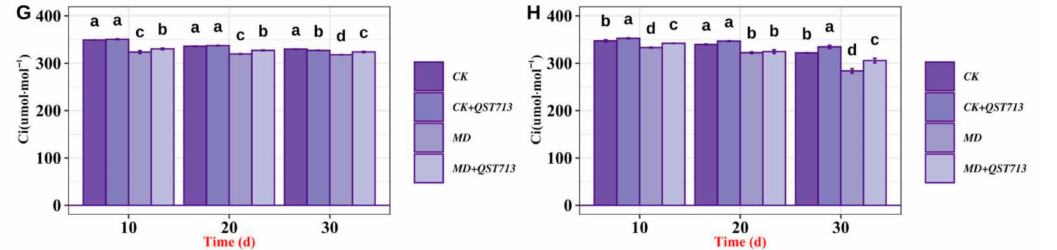
Figure 2. Effect of drought stress and QST713 application on photosynthetic rate (Pn; ( A , B )), transpi- ration rate (Tr; ( C , D )),stomatal conductance (Gs; ( E , F )) and intercellular CO 2 (Ci; ( G , H )) of alfalfa seedlings in two cultivars (( A , C , E , G ), Galalxic Max; ( B , D , F , H ), Saidi 7). Data are the mean ± SE ( n = 3). Different letters indicate significant differences from each other ( p < 0.05).